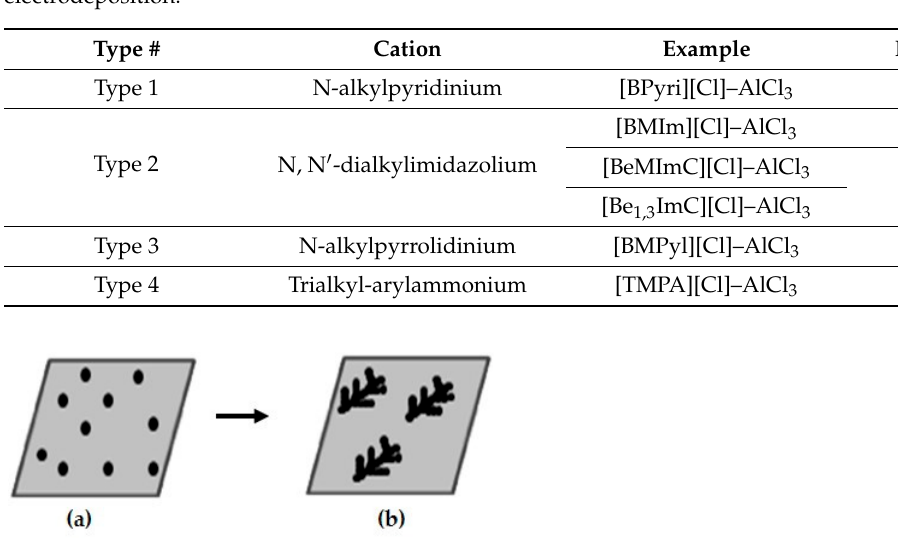
Table 3. Table listing the classification of chloroaluminate-based ionic liquids (ILs) employed for Al electrodeposition.